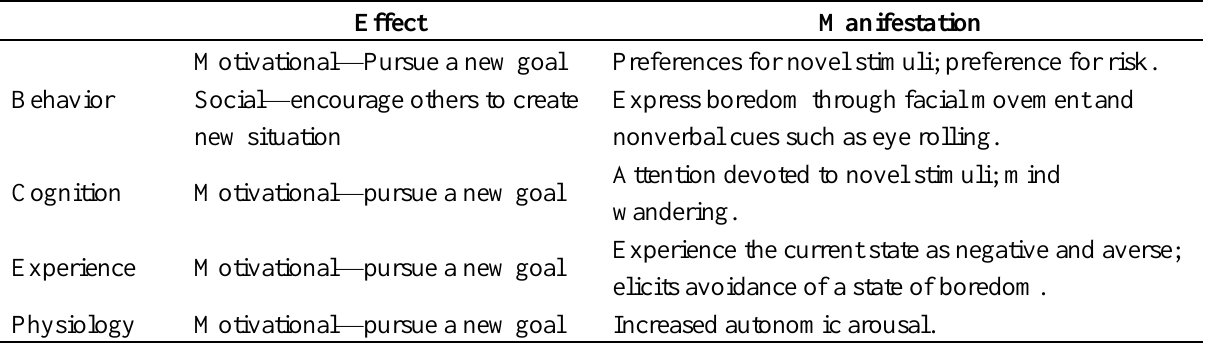
Table 1. Proposed effects of boredom and the manifestation of those